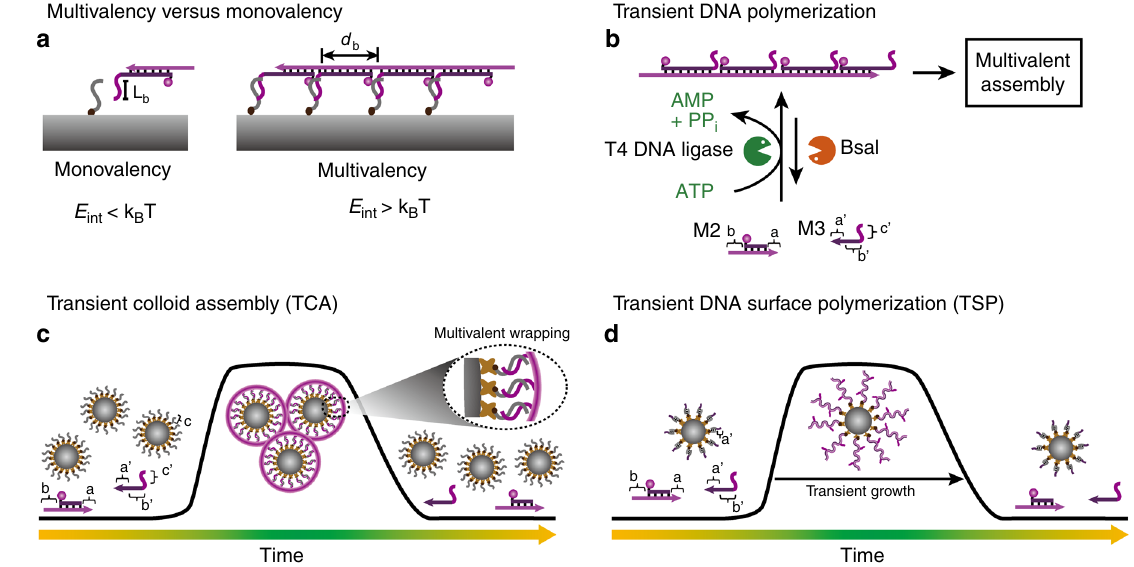
Fig. 4 ATP-fueled hierarchical transduction of multicomponent SfNAPs to colloidal systems. a Monovalent vs. multivalent binding with programmable interaction strength, L b , and branch distance, d b . b Schematic illustration of transient SfNAPs. c Schematic representation of the ATP-fueled transient DNA wrapping-induced TCA. d Schematic representation of ATP-fueled TSP on a colloidal surface by encoding a docking strand on the colloid (a ’ ) that integrates into the main chain of the DySS